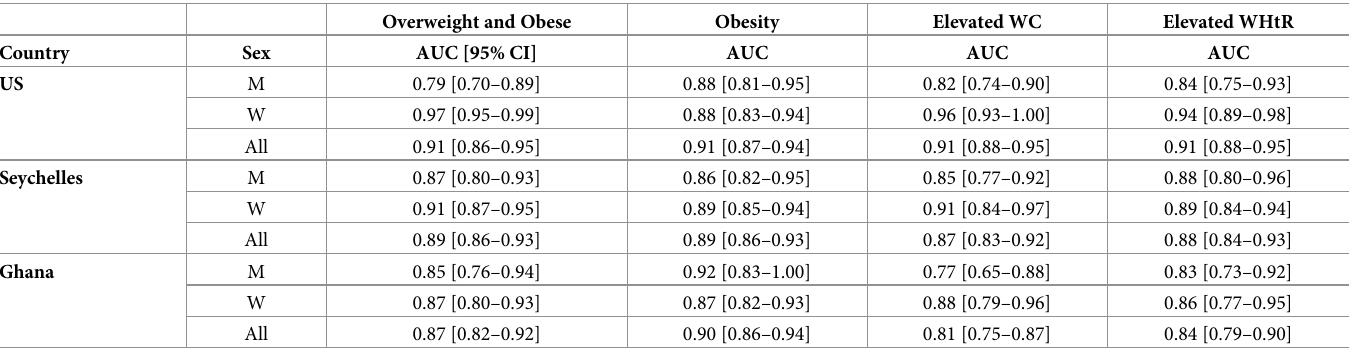
Table 5. Performance of self-reported silhouette ranking to predict overweight and obese BMI, elevated WC, and elevated WHtR in the US, Seychelles, and Ghana. Overweight and Obese Obesity Elevated WC Elevated WHtR